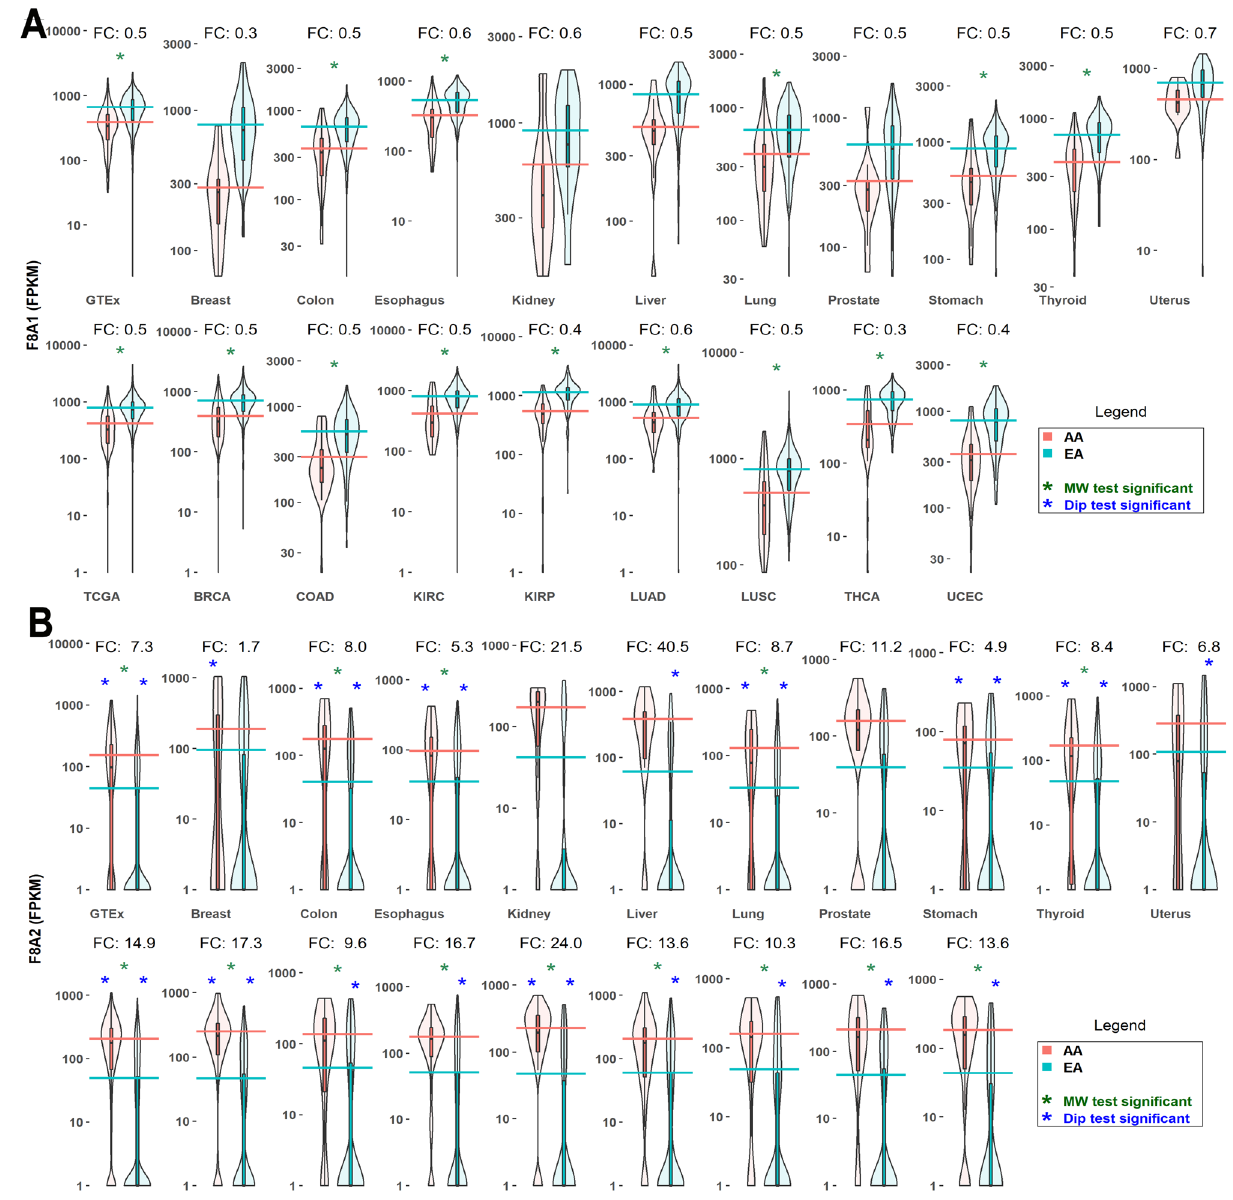
Figure 3. Differential expression of the HAP40 genes F8A1 and F8A2 in African Americans and European Americans across multiple tissue-types. HAP40 is a key molecular component of Huntington’s Disease, and shifts endosomal trafficking from the microtubules to actin fibers 30 . ( A ) F8A1 expression is upregulated in European Americans. ( B ) F8A2 expression is upregulated in African Americans. Violin plots summarize expression over each sample across the two populations. AA African American, EA European American. Horizontal lines represent mean log expression. Green asterisk, MW test for DE significant (BH corrected p value < 0.05 ). Blue asterisk, Hartigans’ dip test. Expression distribution is influenced by differences in population sizes (significant p value < 0.05 ). FC, fold change AA/EA. GTEx and TCGA violin plots represent the pooled samples from each project. DE were computed within MetaOmGraph (MOG) 22 , in MOG’s statistical analysis module; R scripts were executed interactively via MOG to generate the violin plots. (See Supplementary Fig. 2 for line plot comparison across F8A1, F8A2, and F8A3 genes, we further investigated the sequences, sequence variants, and the expression pat- terns of these genes. The sequences of the HAP40-encoding proteins from F8A1, F8A2, and F8A3 are identical to each other in human reference genome GRCh38.p13 (https:// www. ncbi. nlm. nih. gov/ assem bly/ GCF_ 00000 1405. 39). We searched for potential allele variants of HAP40 proteins encoded by F8A1, F8A2, and F8A3 in The Genome Aggregation Database (gnomAD) 33 . gnomAD assigns individuals to populations, by clustering of genetic features.